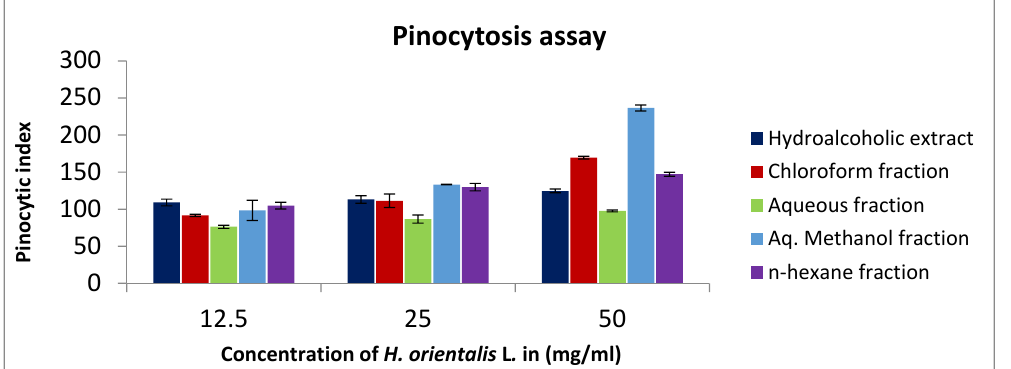
Figure 5. In vitro pinocytic assay using neutral red method on peritoneal macrophages treated with different concentrations (12.5–50 mg/mL) of H. orientalis L. extract and fractions. Aq. Methanol showed the highest pinocytic index (236). Results are expressed as means of three independent experiments (bars) ± SEM